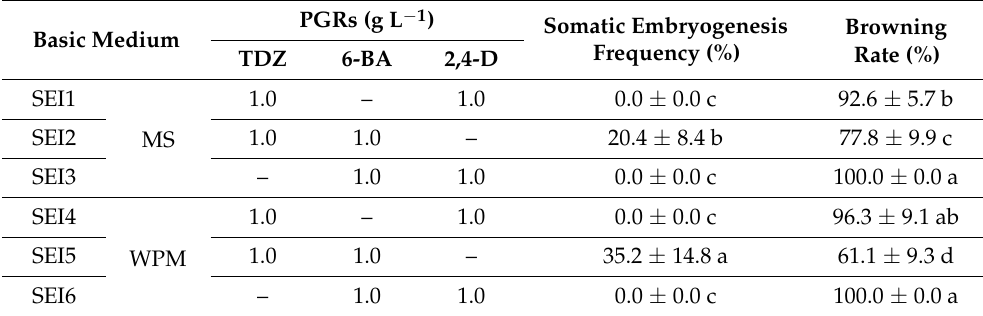
Table 1. Effects of different somatic embryo induction (SEI) media on the somatic embryogenesis frequency and the browning rate of the immature seeds after 2 months of